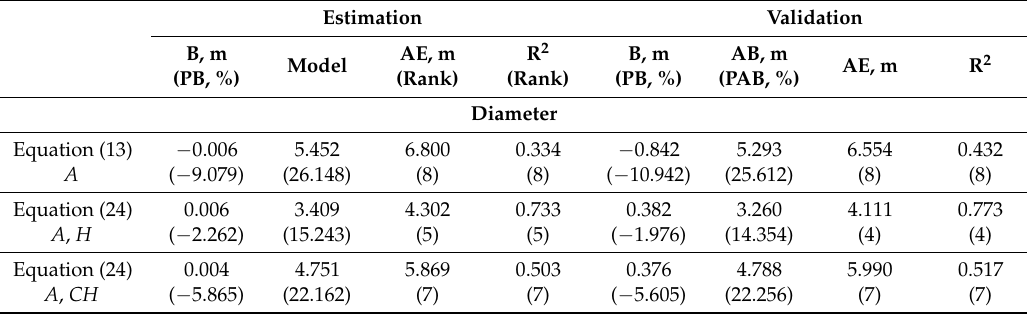
Table 2. Statistical indexes for all models applied to the estimation and validation datasets.